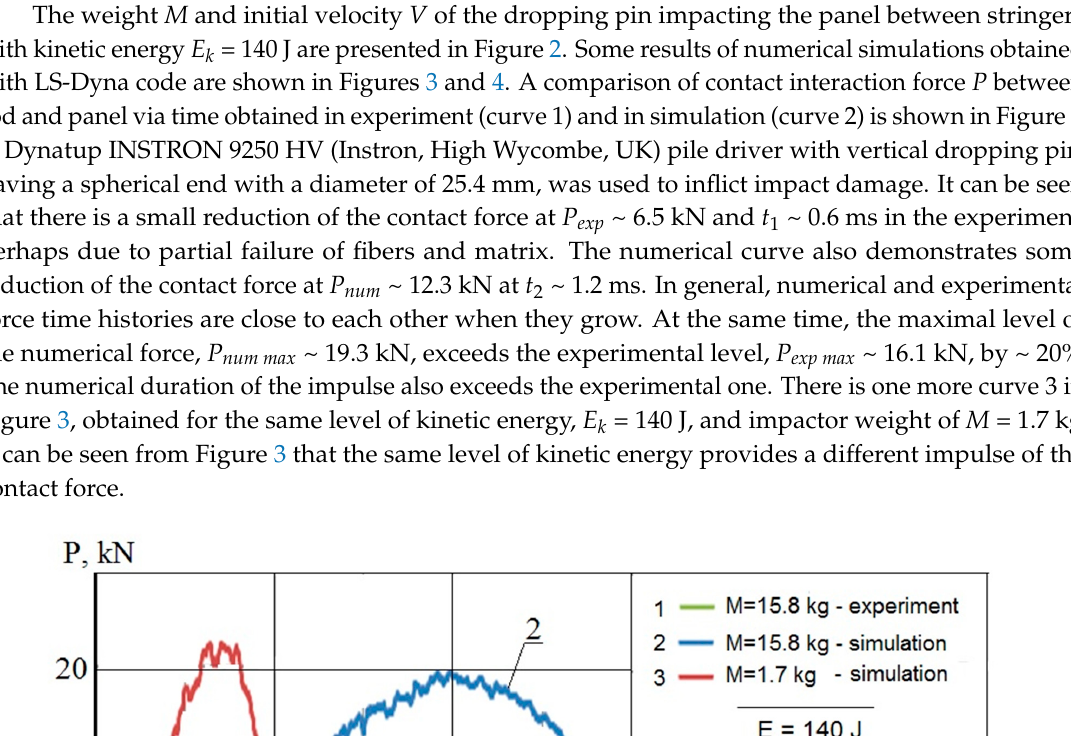
Figure 2. Fragment of the panel finite-element model. V —the impactor initial velocity, M —the impactor weight.